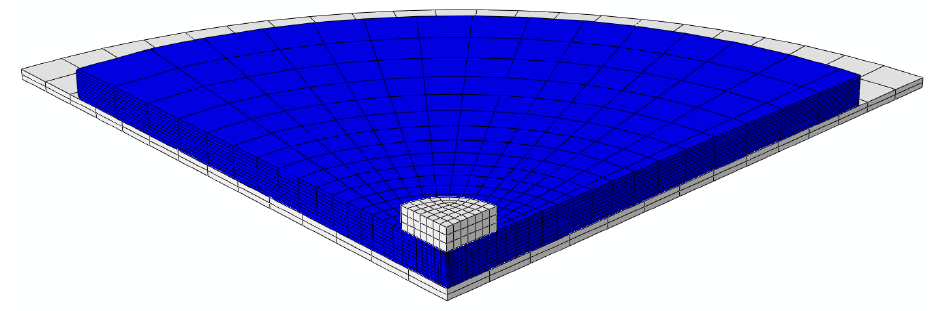
Figure 3. Abaqus model of test condition B, base plate and compression foot (white) are modelled as rigid bodies and sandwich the shockpad (blue).